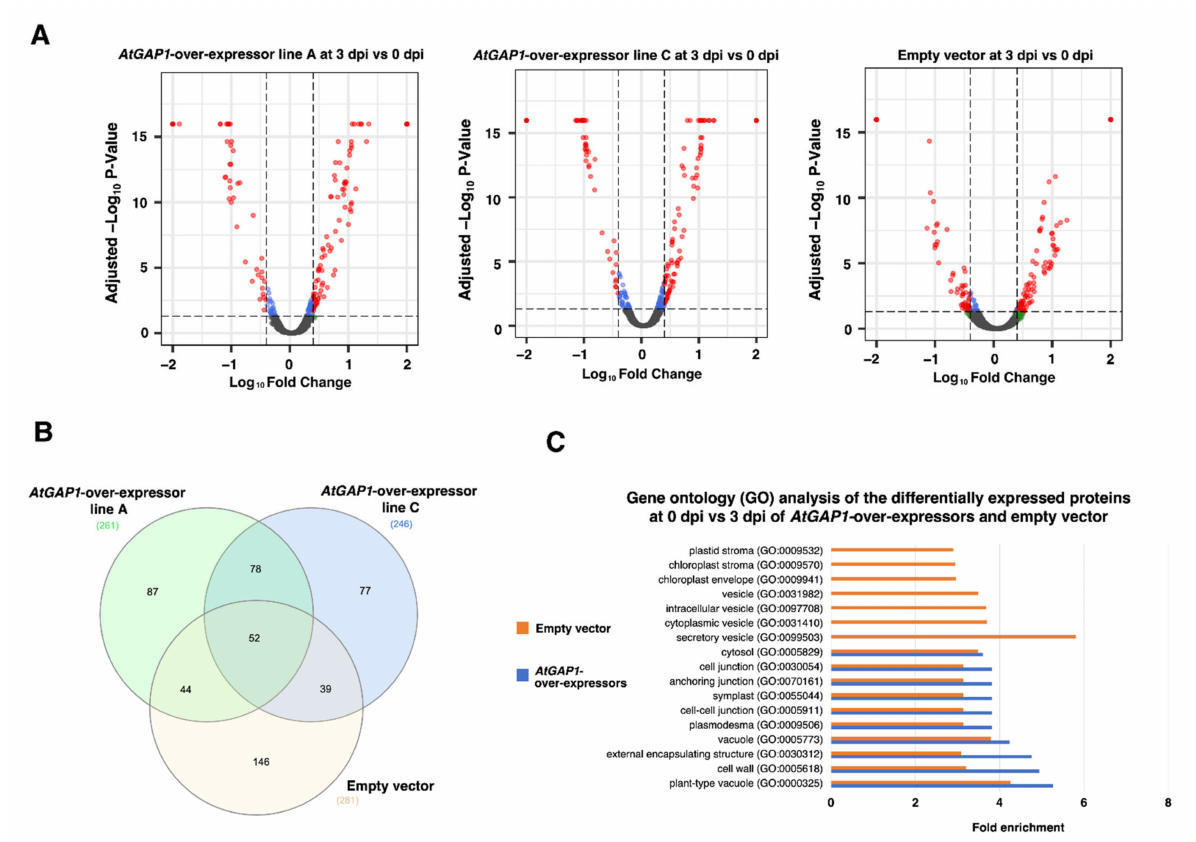
Figure 3. AtGAP1 -overexpressors showed a more significant enrichment in cell-wall-related proteins in their differential protein expression profiles after the inoculation of Pst DC3000 than the empty vector control. The rosette leaves of five-week-old Arabidopsis plants, including the empty vector control and AtGAP1 overexpressors (independent lines A and C) were inoculated with Pst DC3000. Total protein was extracted from the aerial part of the plants for protein-expression profiling. ( A ) Vol- cano plots showing the fold-changes in protein abundance between 3 days post-inoculation (dpi) and 0 dpi in AtGAP1 -overexpressor line A, AtGAP1 -overexpressor line C, and the empty vector control. The statistical significance of differential protein expression was calculated using Student’s t-test based on the default parameters in Proteome Discoverer v2.4 (Thermo Fisher Scientific, Waltham, MA, USA). The -log 10 -transformed p -value (Benjamini–Hochberg adjusted − log 10 p -value) was plotted against log 10 -transformed protein quantity ratios for all proteins between 3 and 0 dpi in AtGAP1 - overexpressors and the empty vector control. The volcano plot is generated via the R-based package EnhancedVolcano (ver. 1.0.1; https://github.com/kevinblighe/EnhancedVolcano (accessed on 30 April 2022) [57]). Differentially expressed protein with Benjamini–Hochberg adjusted p -value < 0.05 and log 10 (|fold change|) > 0.48 (equivalent to 3-fold changes) were plotted in red. Proteins with log 10 (|fold change|) > 0.48 but with adjusted p -value ≥ 0.05 were plotted in green, and proteins with log 10 (|fold change|) ≤ 0.48 with adjusted p -value < 0.05 were plotted in blue. ( B ) Venn diagram showing the numbers of differentially expressed proteins after Pst DC3000 inoculation that were common between AtGAP1 -overexpressors and the empty vector control. ( C ) Gene ontology (GO) analysis of the differentially expressed proteins in AtGAP1 -overexpressing lines and the empty vector control between 3 and 0 dpi. The lists of differentially expressed proteins were compared using PANTHER from The Arabidopsis Information Resources (TAIR) database for the GO-term enrichment in cellular components. The GO terms with fold enrichment > 2 and adjusted p -value < 0.05 were listed. Each biological replicate was pooled from three individual plants of the same line. The results were the average of three biological replicates analyzed using Proteome Discoverer v2.4. (Thermo Fisher Scientific, Waltham, MA,